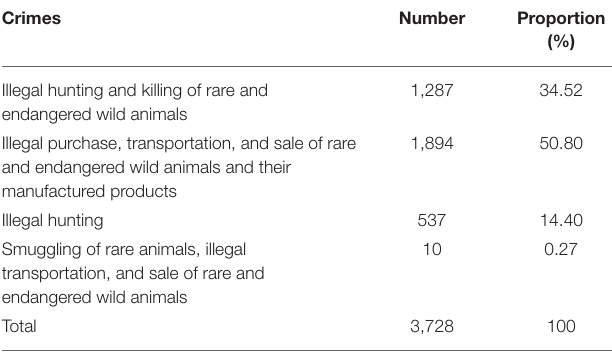
TABLE 1 | Wildlife crimes